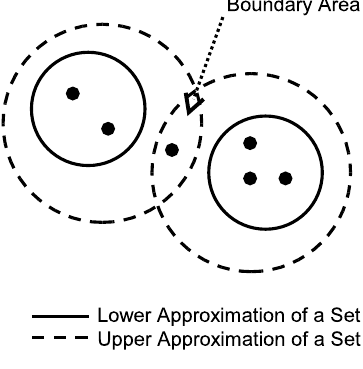
Fig. 1. Lower and Upper Approximations.